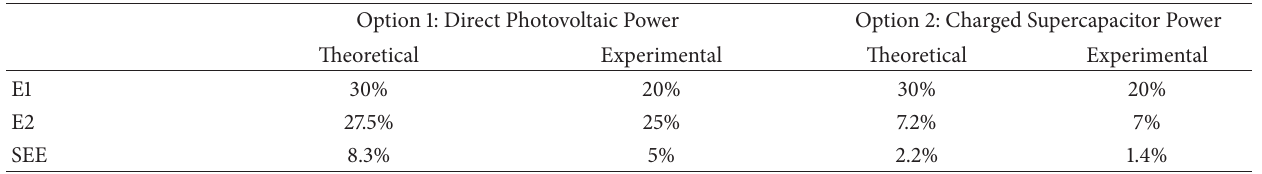
Table 3: System Energy Efficiency